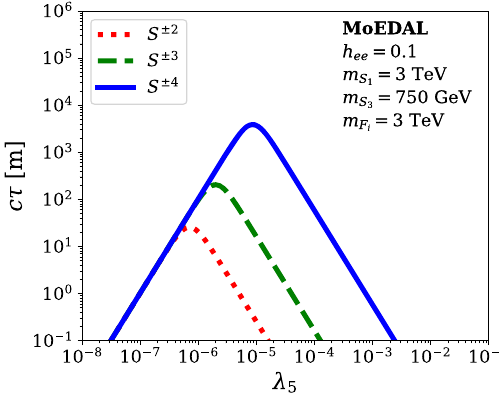
Fig. 6 Lifetimes of multi-charged particles, S ± 4 (blue solid) S ± 3 (green dashed) and S ± 2 (red dotted), in Model-1 as functions of λ 5 , where h F and h ¯ are fitted to the neutrino data. The m S F